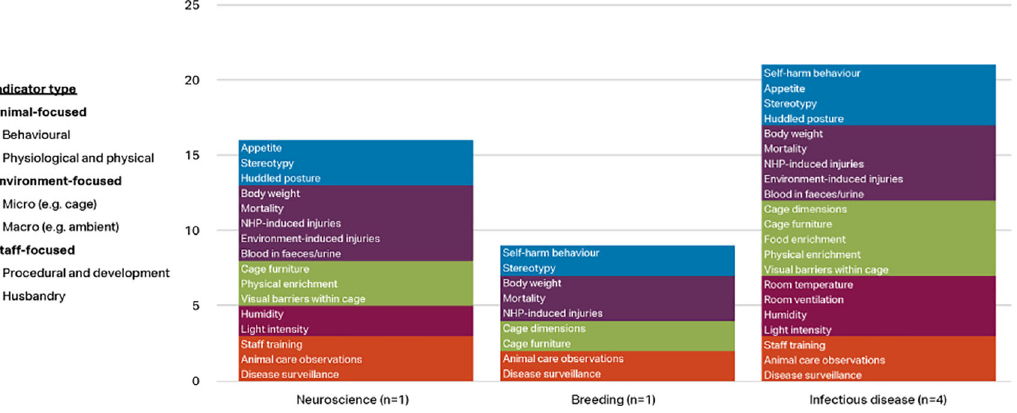
Figure 6. Indicators chosen as reliable and valid by two-thirds of respondents, marmosets by discipline and indicator type (n=6